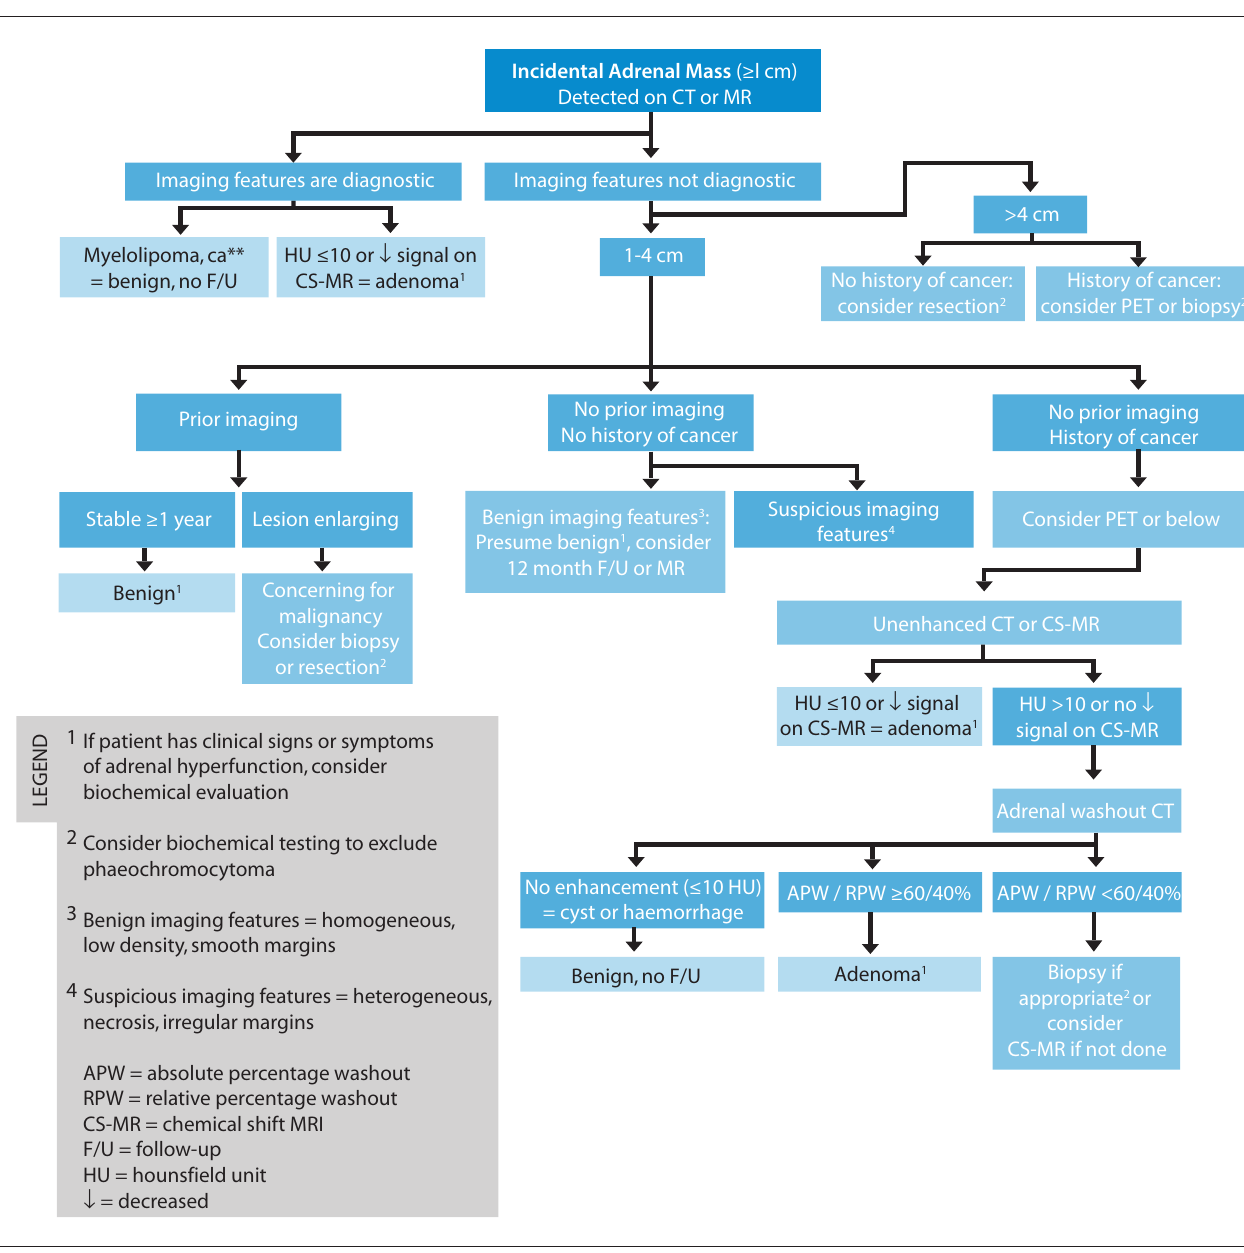
Fig. 13. American College of Radiology White Paper-recommended algorithm for the management of an adrenal incidentaloma (by courtesy of Dr L L Berland).